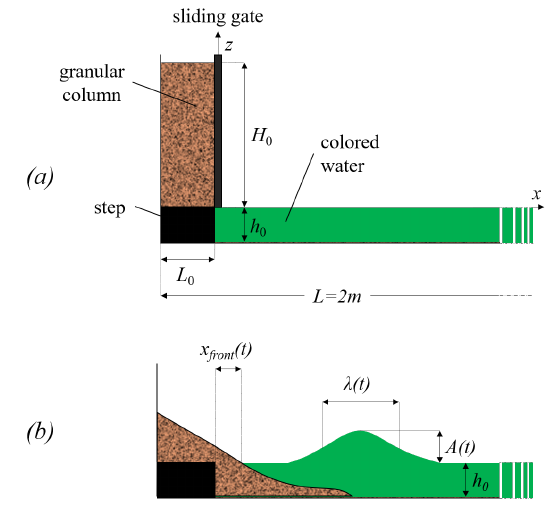
Figure 1. Sketch of the experimental setup : (a) initial subaerial configuration for the granular column and the water tank, and (b) parameters of interest, for both the granular collapse and the generated water